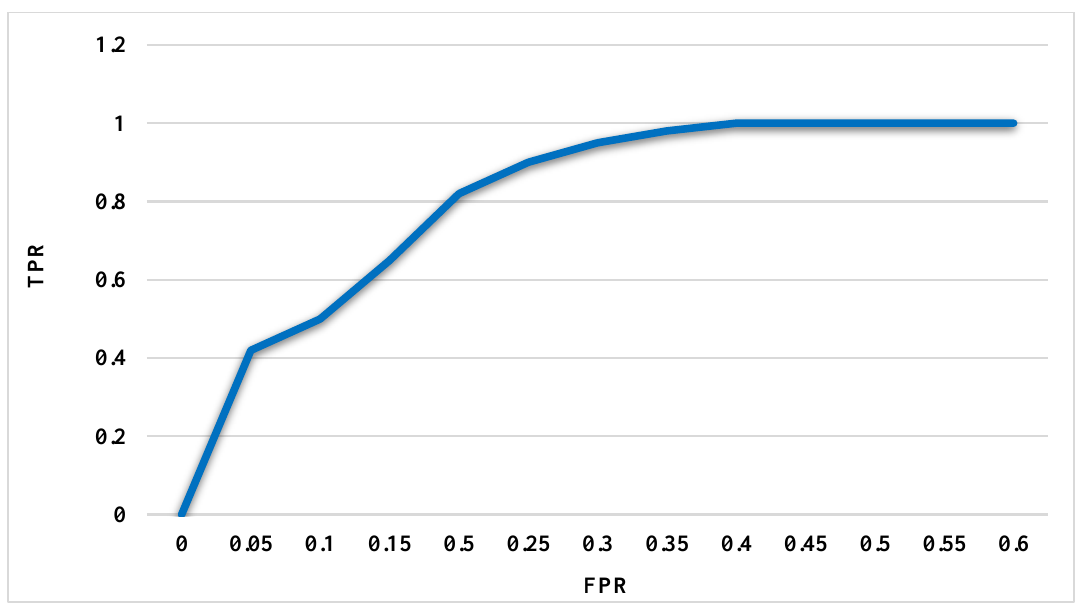
Figure 3. ROC analysis for the CSE-CIC-IDS 2018 dataset. Table 2. BoT-IoT dataset.